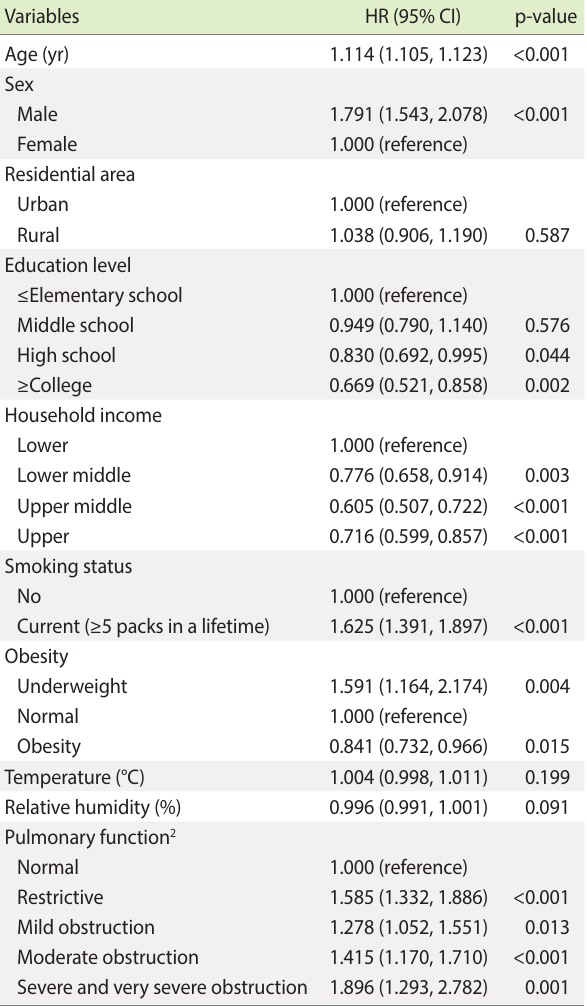
Table 4. Hazard ratios (HR) and 95% confidence intervals (CI) of pul- monary function for all-cause death using Cox proportional